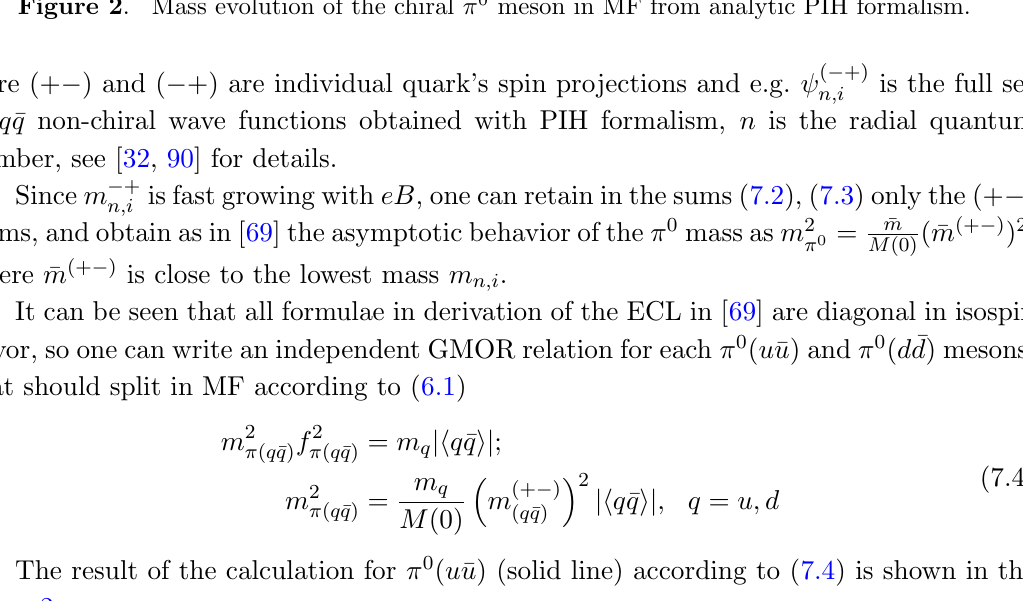
Figure 2 . Mass evolution of the chiral (cid:25) 0 meson in MF from analytic PIH